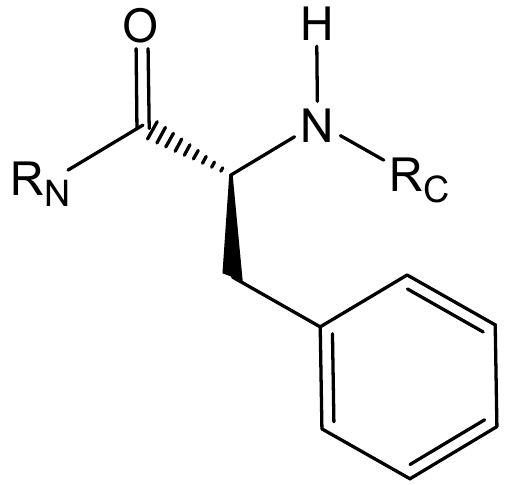
Figure 9. Hydrogens in phenilalanine.